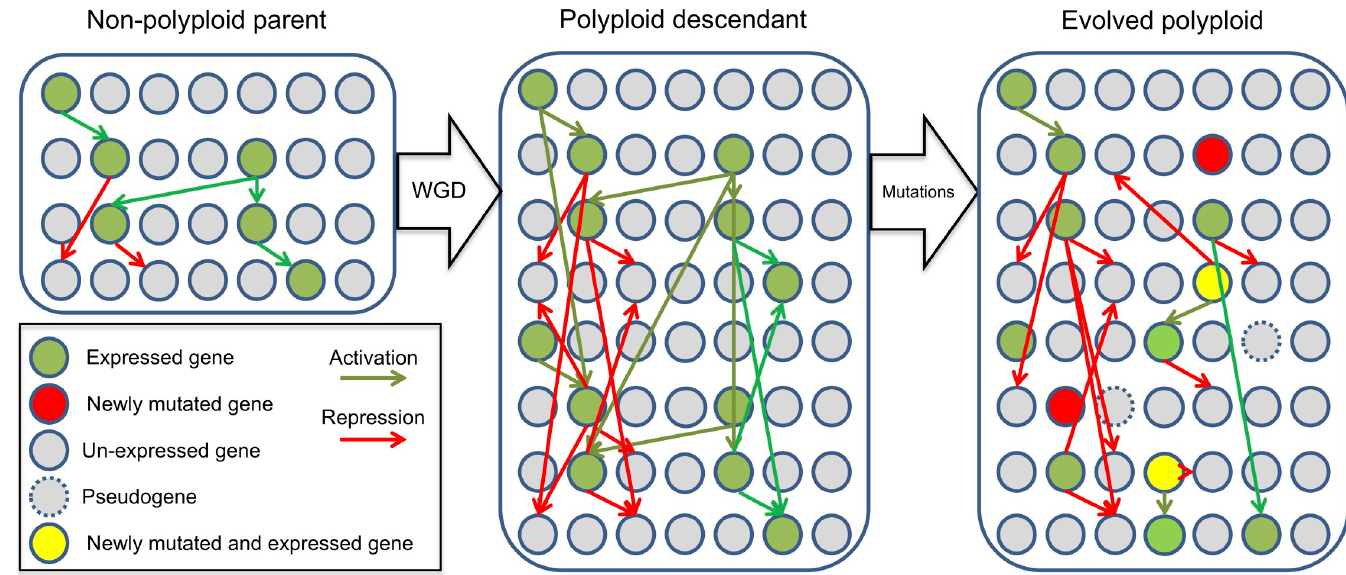
Fig 3. Evolution of a DO under specific WGD and substitution mutation rates. At the beginning of the simulation, the WGD rate is fixed at 40%. Once non- polyploid and polyploid populations sizes have reached equilibrium, the WGD operator is removed from the simulation. Similarly, at every replication step, a fixed substitution rate (10 − 4 per base) is